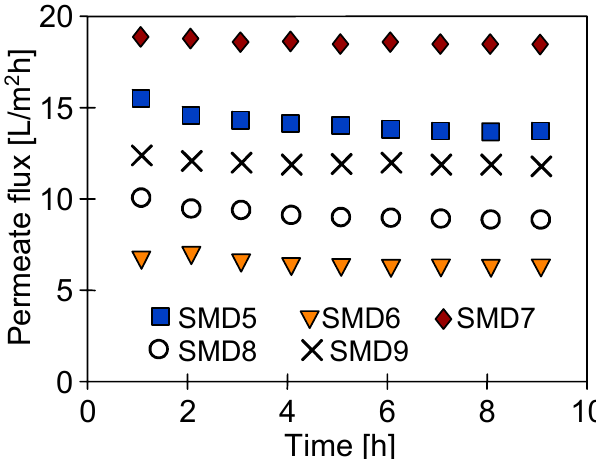
Figure 10. The influence of membrane type on the permeate flux. Mode 1: T F = 353 K. Membranes: SMD5—Accurel PP S6 / 2; SMD6—Accurel PP V8 / 2 HF; SMD7—HL310; SMD8—PV370; and SMD9—K1800.